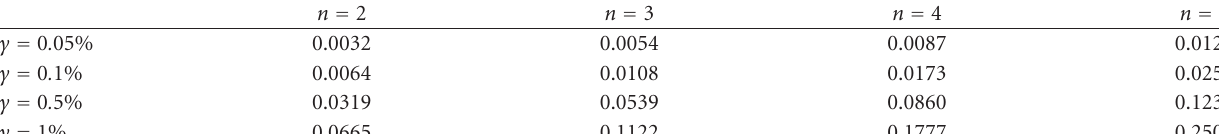
Table 4: Relative error between frequency shifts relevant to the imperfect rotor, evaluated according to the HOM model and the L-HOM model. The imperfection is introduced by increasing the mass of the fourth blade of the perfect rotor described in Section 4.1 by γ = 0 . 05%, 0 . 1%, 0 . 5%, and 1%, with respect to its nominal value. Modal frequencies relevant to modal numbers n = 2 · · · 5 and l = 1.